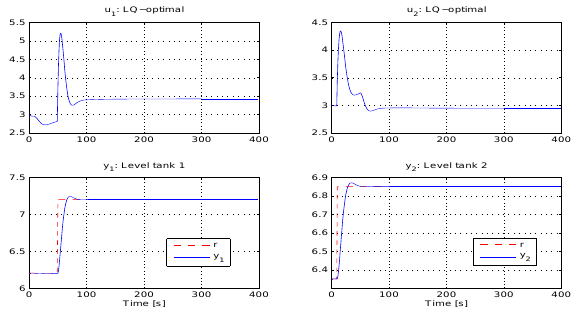
Figure 1: Simulation of the quadruple tank process and the minimum phase case in Example 6.1 with LQ optimal control with integral action.